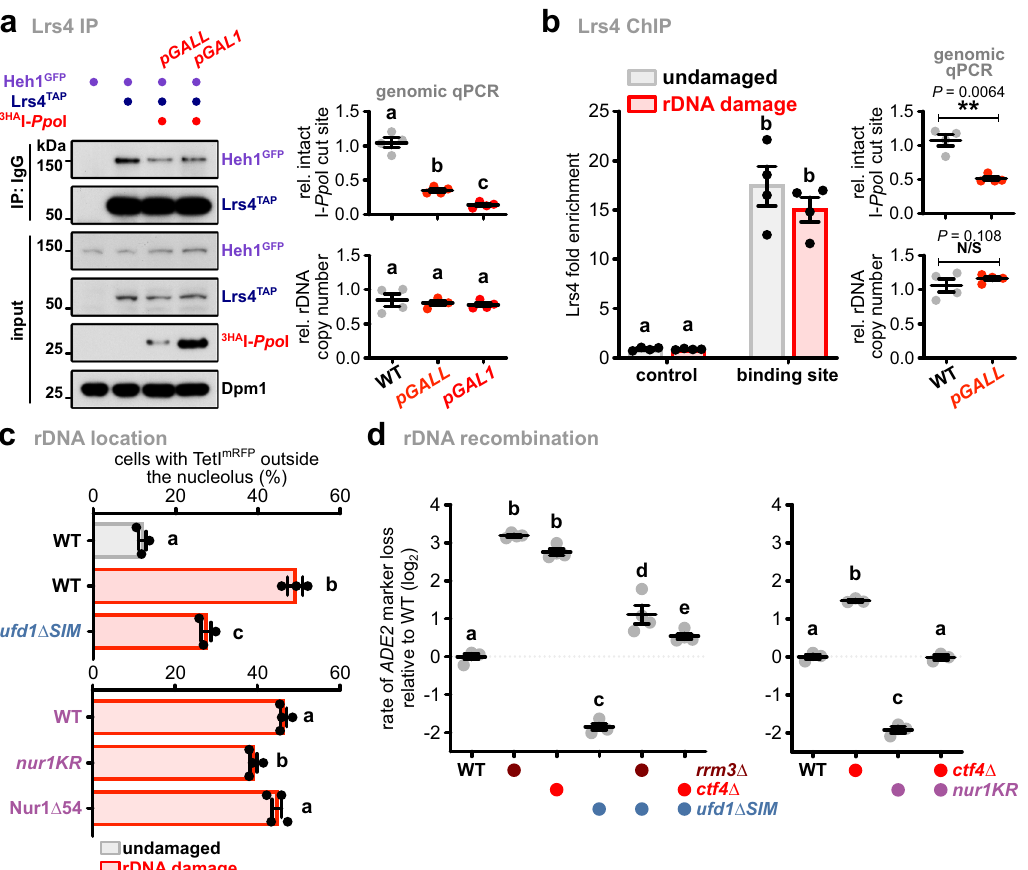
Fig. 7 DNA damage contributes to CLIP-cohibin disassembly and Cdc48-dependent nucleolar rDNA release. a Co-immunoprecipitation of Heh1 GFP with Lrs4 TAP in cells with or without rDNA damage generated by 3HA I- Ppo I expression. Dpm1 served as loading control. Quanti fi cation of double-strand break (DSB) induction (top right) and rDNA copy number (bottom right) relative to undamaged cells is shown ( n = 4 independent biological experiments). b Lrs4 TAP binding to rDNA repeats in cells with or without rDNA damage, quanti fi ed by ChIP-qPCR ( n = 4 independent biological experiments). The ChIP values are shown as Lrs4 fold enrichment over the average of three rDNA positions, after normalization to input. Quanti fi cation of double-strand break (DSB) induction (top right) and rDNA copy number (bottom right) relative to undamaged cells is shown ( n = 4 independent biological experiments), and the statistical analysis was performed using two-tailed Student ’ s t -test. c Percentage of WT and ufd1 Δ SIM cells (top; n = 3) or expressing Nur1 full-length (WT), the SUMOylation de fi cient mutant ( nur1KR ) or lacking its last 54 residues (Nur1 Δ 54) (bottom; n = 4), with rDNA repeats localized outside the nucleolus before and after DSB induction, quanti fi ed as in Fig. 2. d Quanti fi cation of rDNA recombination rates in the indicated strains (left, n = 4; right, n